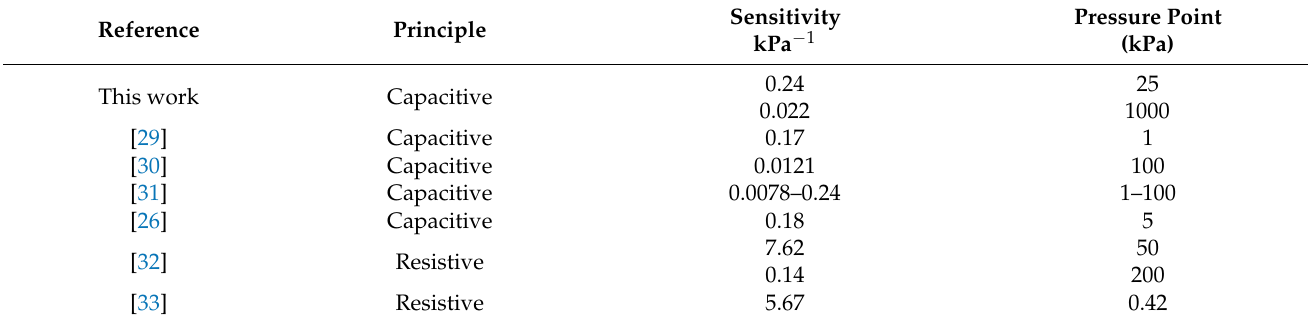
Table 3. Comparison of the proposed sensor with reported